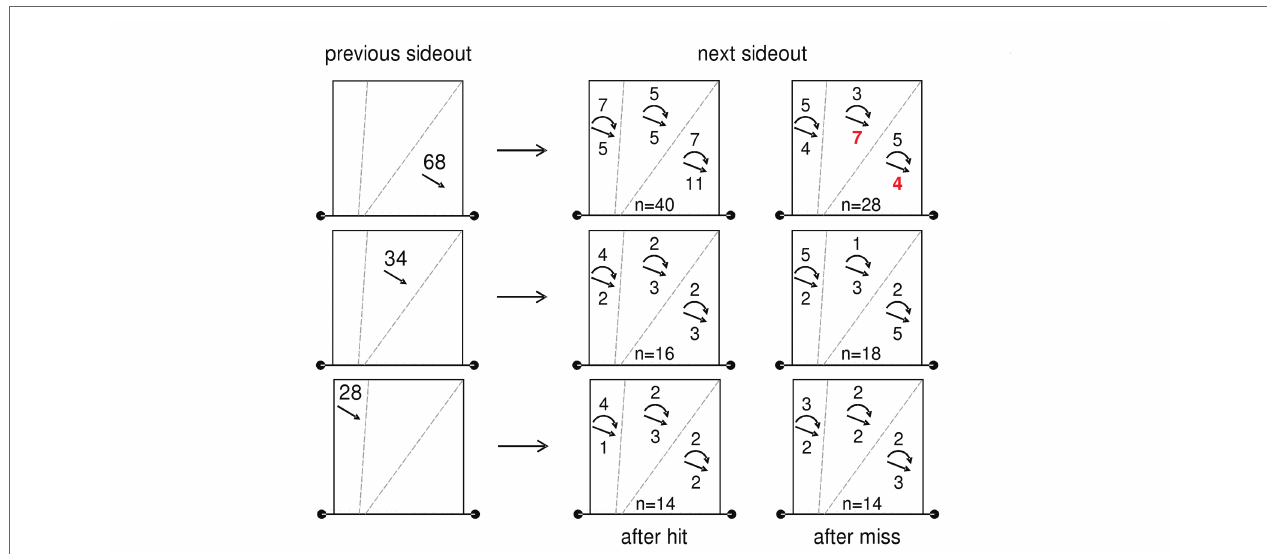
FIGURE 3 | Match report used for supporting German national beach volleyball teams. It shows the profile of one female player in eight matches. Data include sideout sequences in which the previous sideout was played with a spike. The three courts in the left column show the number of spikes played diagonal ( n = 68), mid ( n = 34), and line ( n = 28) in the previous sideouts. The other courts show direction (line, mid, diagonal) and technique (curved line with arrow ≙ shot, straight line with arrow ≙ spike) of attacks in the next sideouts after successful sideouts (second column) and after failure (third column). In this structure, e.g., the second court in the third row shows data of all sideouts after successful line